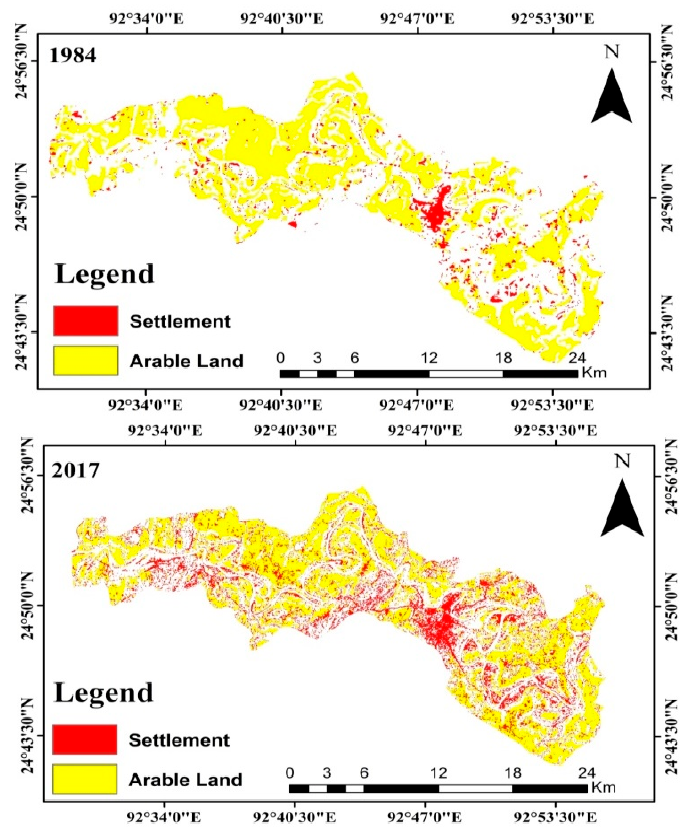
Figure 4. Settlement and arable lands of the Barak River.